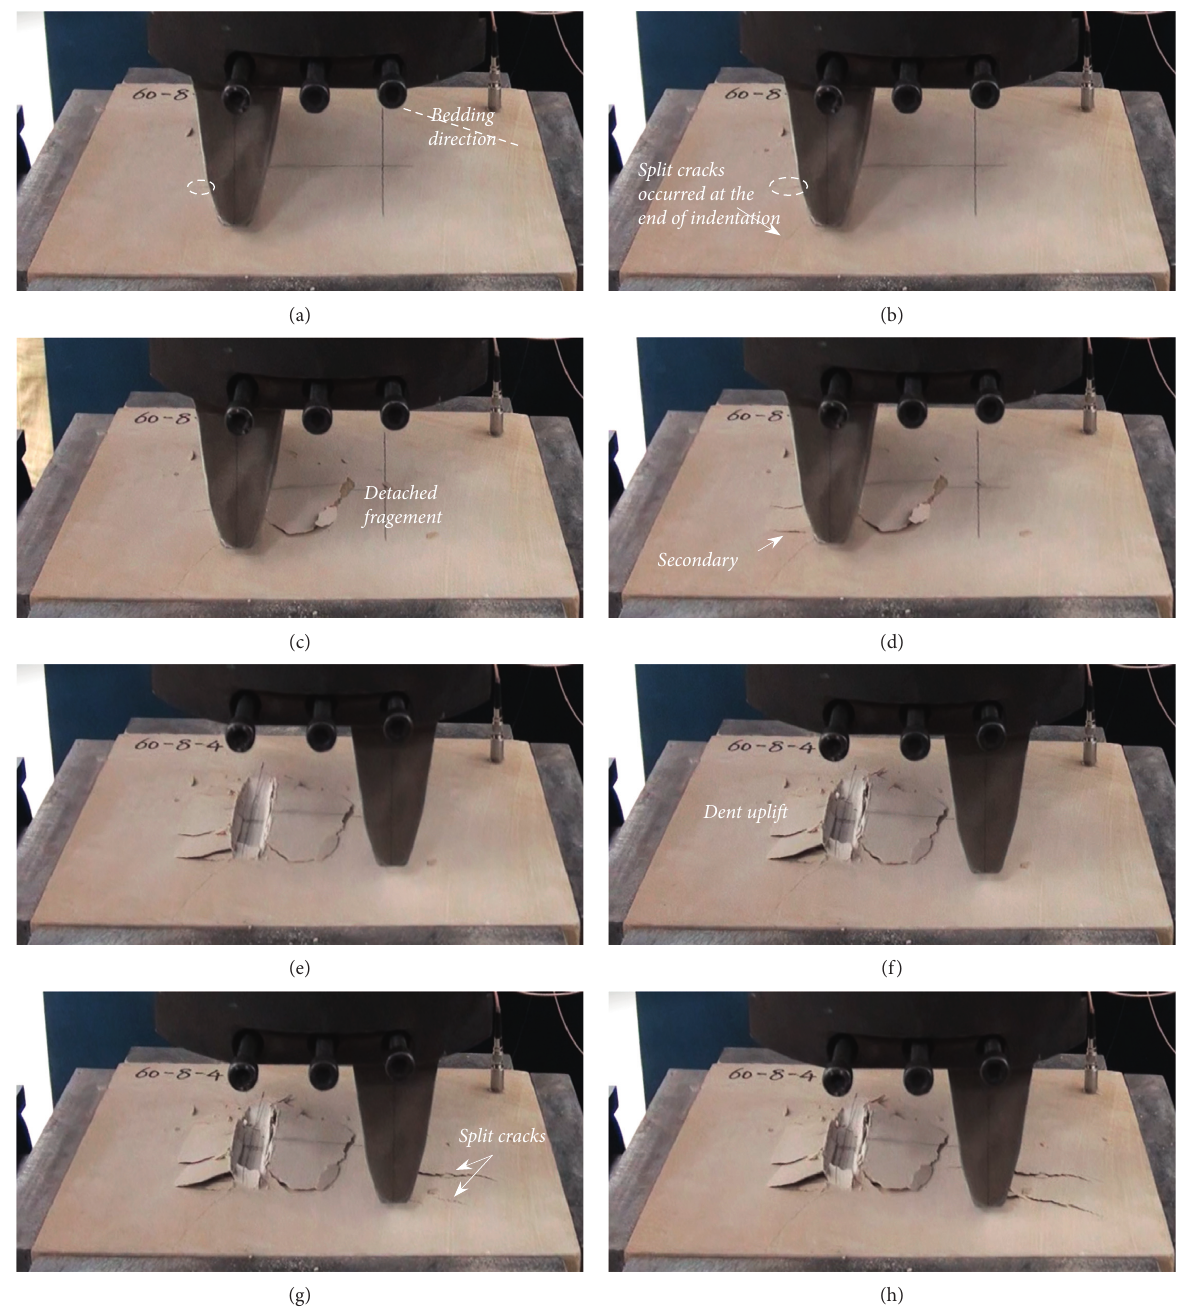
Figure 10: Surface crack evolution of the α � 60 ° specimen under a maximum principal stress of